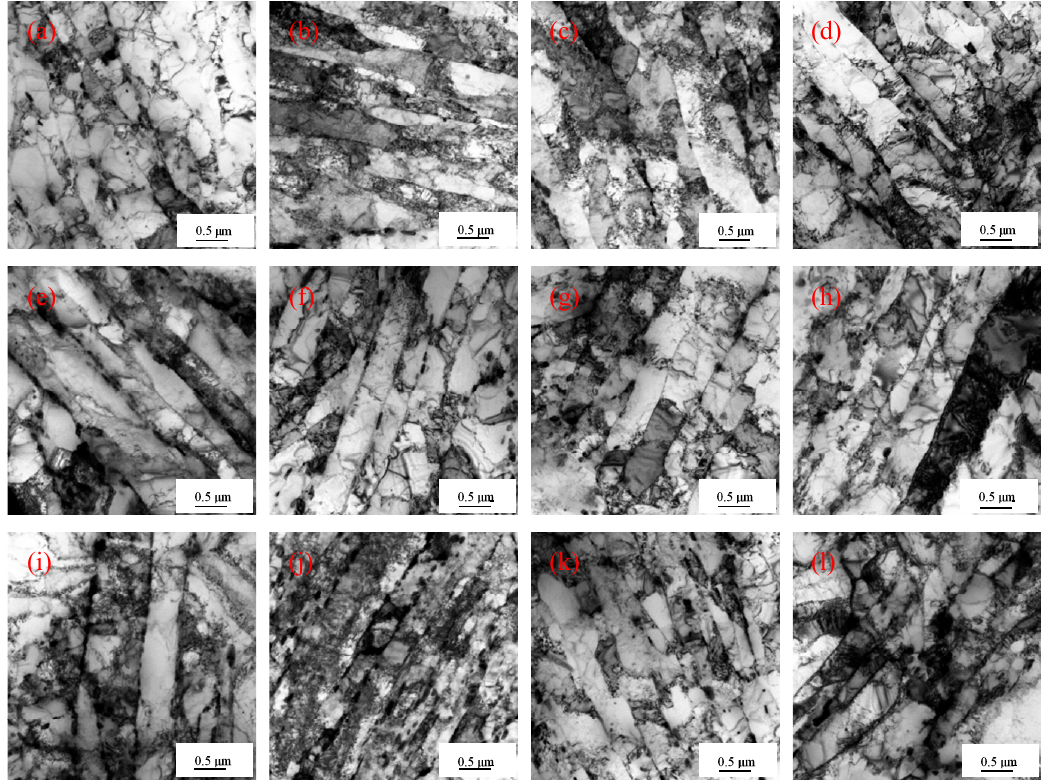
Table 3. Width of the martensite lath in steels aged for different durations ( μ m).